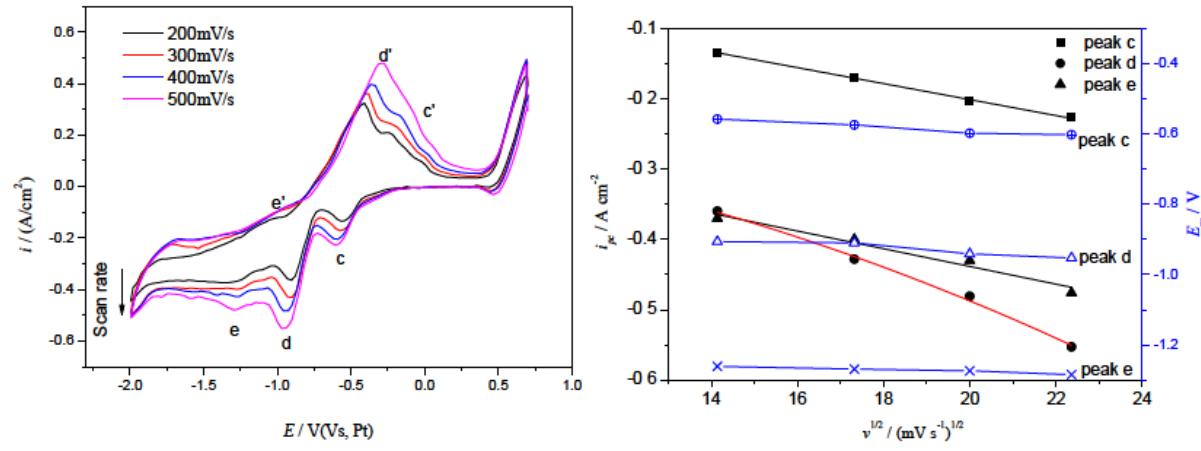
Figure 9: Cyclic voltammetry curves of different scanning speeds of NaCl-KCl-Na-MoO 3 (a) Cyclic voltammetry curve (b) i pc ~ v 1/2 & E pc ~ v 1/2 curve (rate scan: 200-500mV/s, vs Pt)